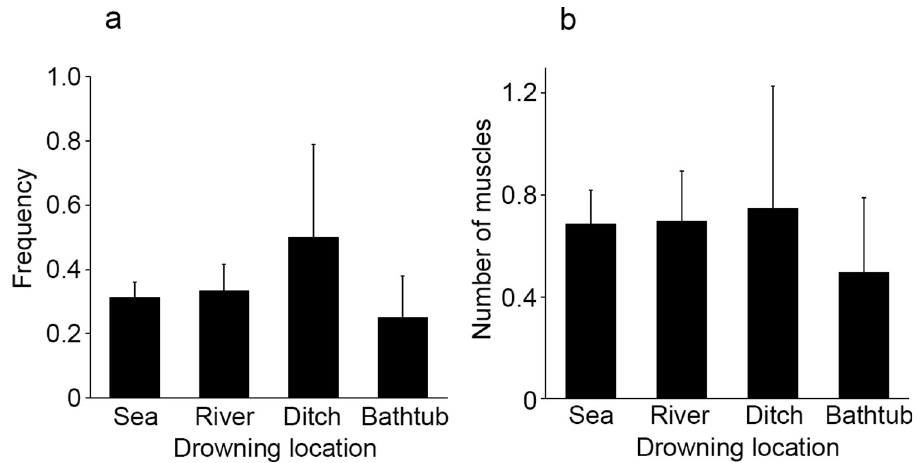
Fig 4. Comparison of the frequency of intramuscular hemorrhage (a) and the number of muscles with hemorrhage (b) at the drowning site. All values represent the mean ± SEM.